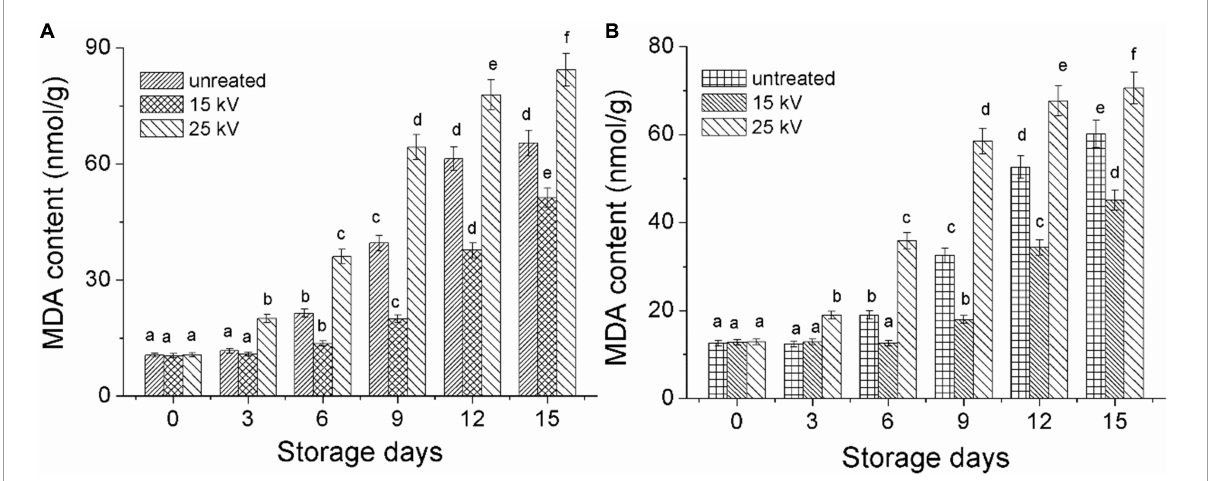
FIGURE8 Changes in MDA content of foxtail millet during accelerated aging storage. (A) Mizhi. (B) Ansai. Different letters with the same column are significantly different ( p <